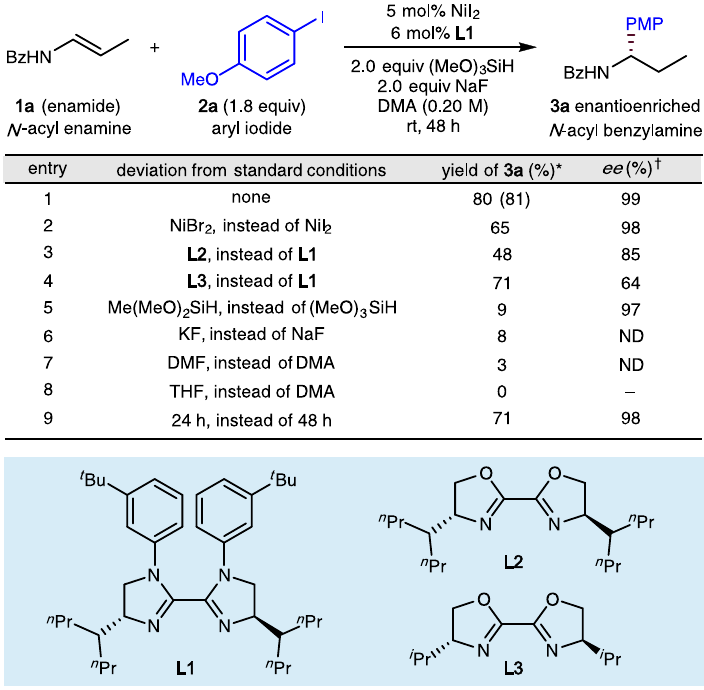
Fig. 2 Variation of reaction parameters. *Yields determined by crude 1 H NMR using 1,1,2,2-tetrachloroethane as the internal standard, the yield in parentheses is the isolated yield. † Enantioselectivity was determined by chiral HPLC analysis. Bz benzoyl, PMP p -methoxyphenyl, DMA N